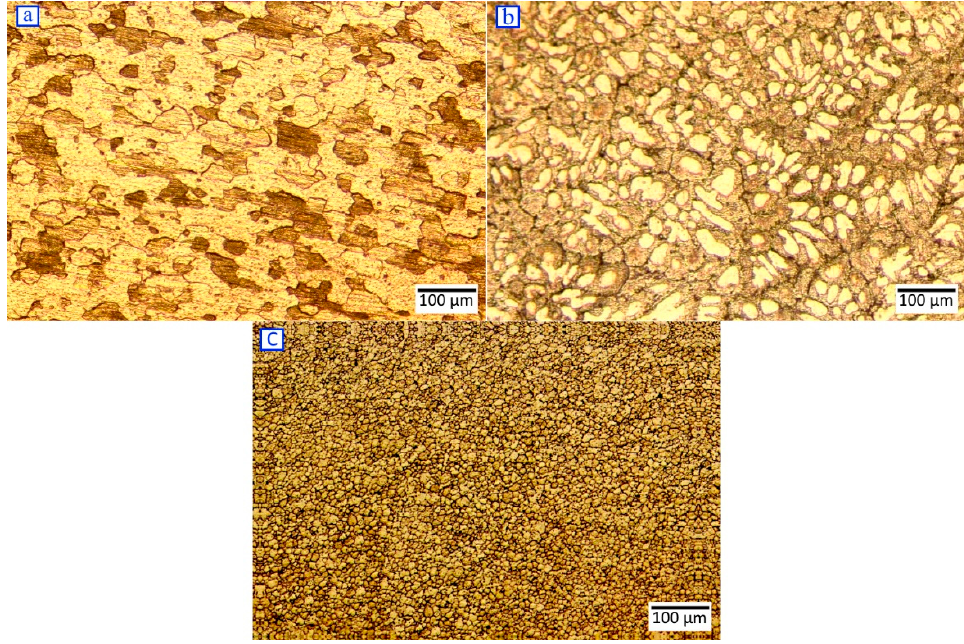
Figure 7. The microstructure of ( a ) the base alloy, ( b ) unprocessed, and ( c ) friction-stir-processed welds.